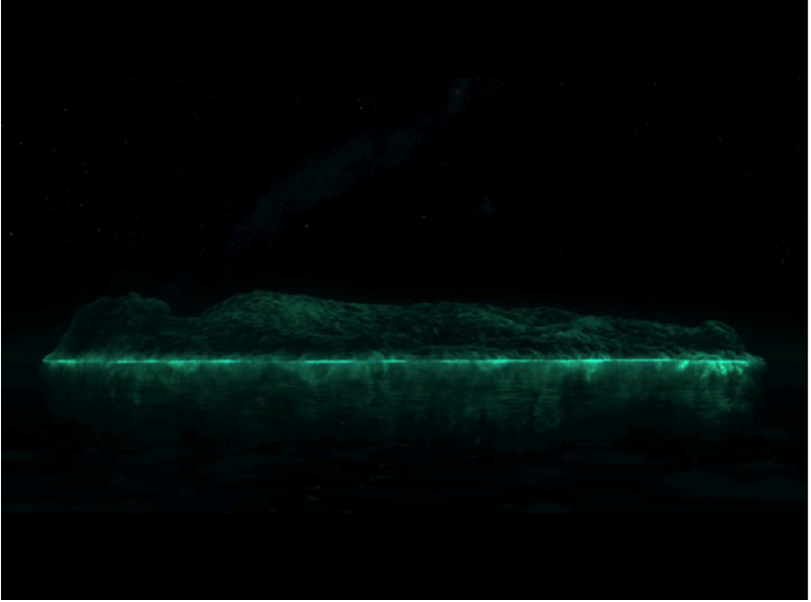
Figure 7. The island reclines, a Vishnu figure asleep on the ocean.